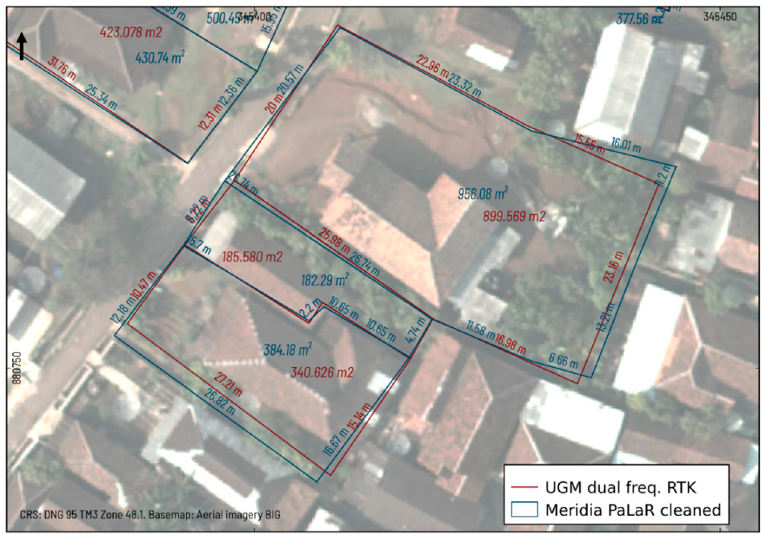
Figure 5. Differences in results in the area and length of the evaluation (uncleaned) and reference (cleaned) data.